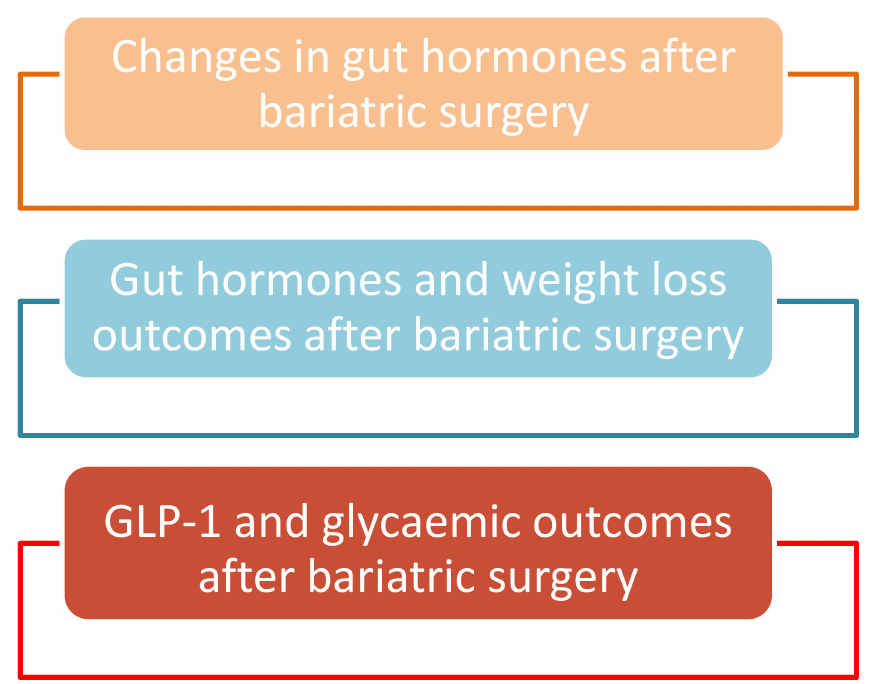
Figure 1. Structure of the review